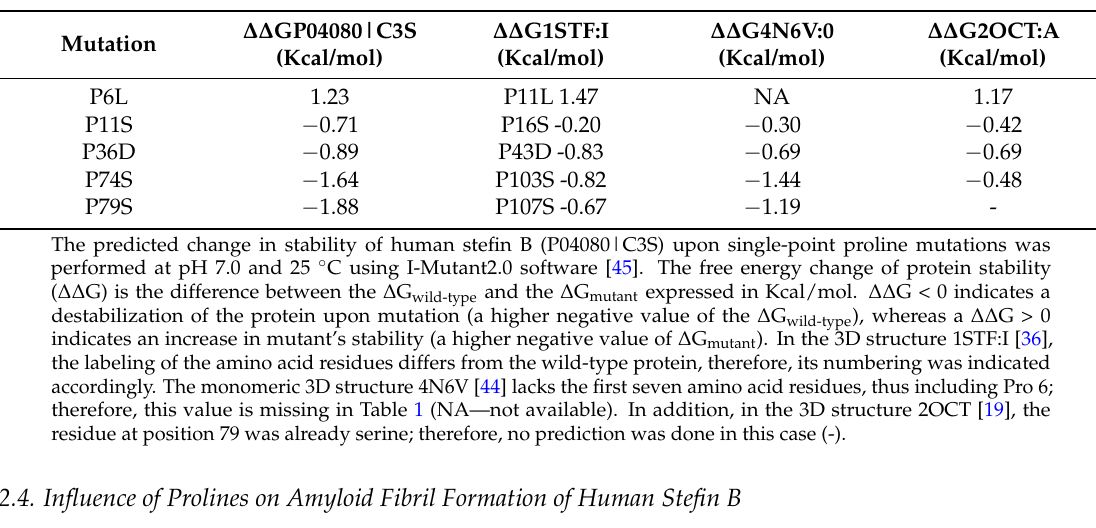
Table 1. Prediction of human stefin B stability upon proline